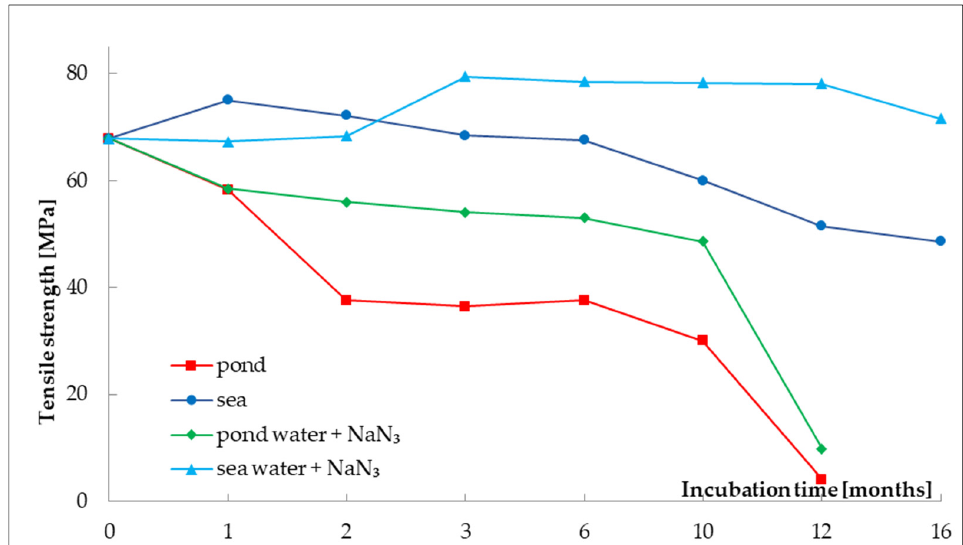
Figure 6. Tensile strength [MPa] of PLA samples after incubation in different aqueous environments. Source: Own research.